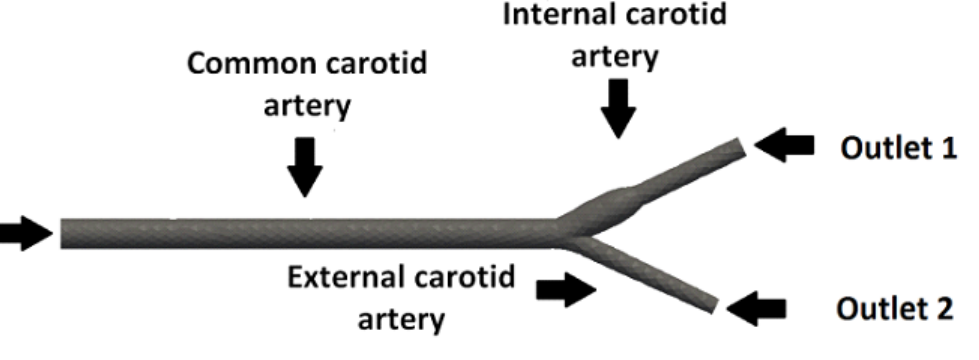
Figure 1. Carotid geometry.